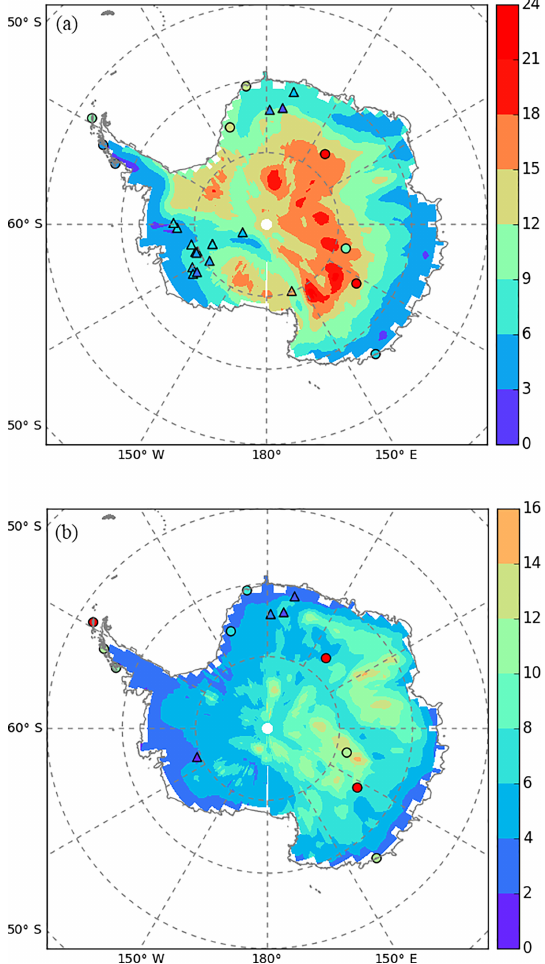
Figure 7. Average seasonal amplitude of precipitation δ 18 O (a) and d (b) (in ‰) simulated by ECHAM5-wiso (colour shading) over the period 1979–2013 and calculated from precipitation data (cir- cles) and ice core records (triangles) over their respective available periods.